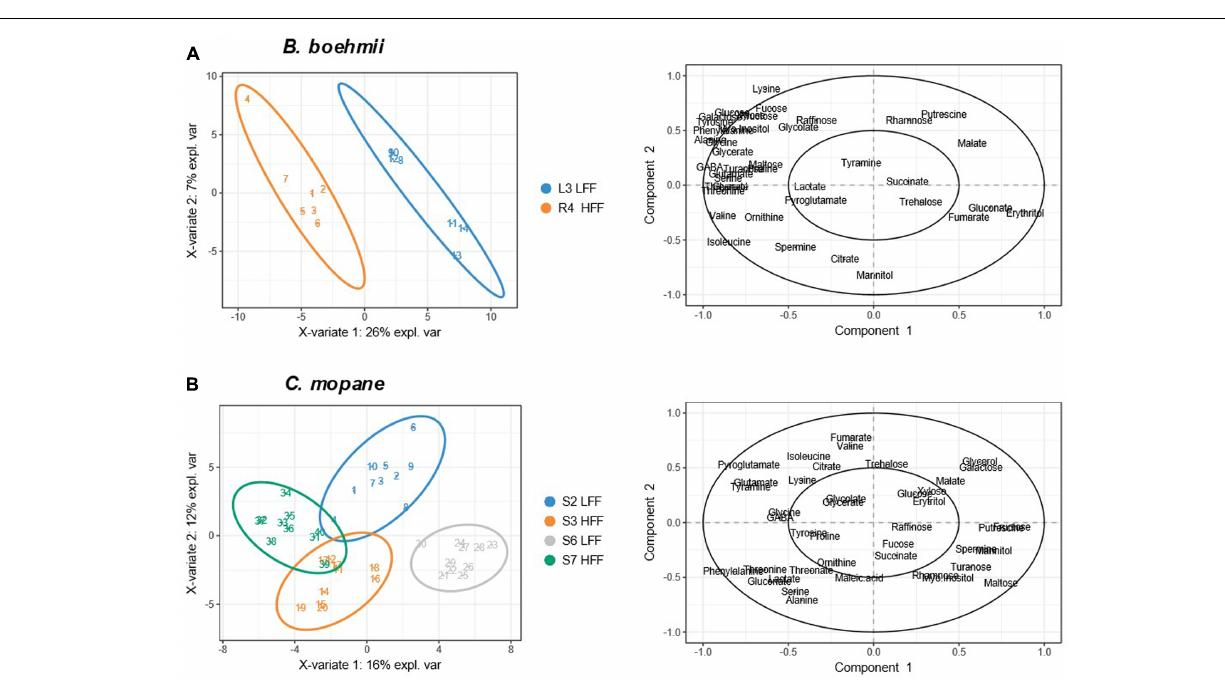
FIGURE 7 | Partial Least Square Discrimination (PLS-DA) score and loading plots for (A) B. boehmii under low fire frequency (L3) and high fire frequency (R4) and (B) C. mopane under different fire frequency regimes, low fire frequency (S6 and S2) and high fire frequency (S7 and